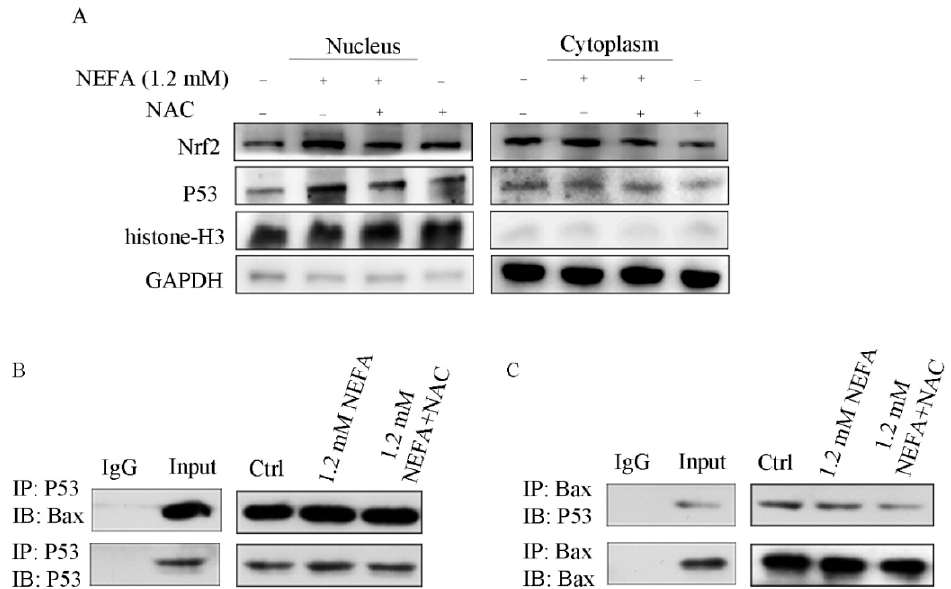
Figure 7. The ROS mediated apoptosis induced by NEFA is regulated by Nrf2 / HO-1 and p53 / Bax signaling pathways. ( A ) The nuclear levels of Nrf2 and p53 were detected by immunoblotting. ( B , C ) The interaction between p53 and Bax is detected by performing co-immunoprecipitation (co-IP) experiments in GCs. The results showed that Nrf2 / HO-1 and p53 / Bax signaling pathways were involved in NEFA induced apoptosis. “ + ”, add; “-” without